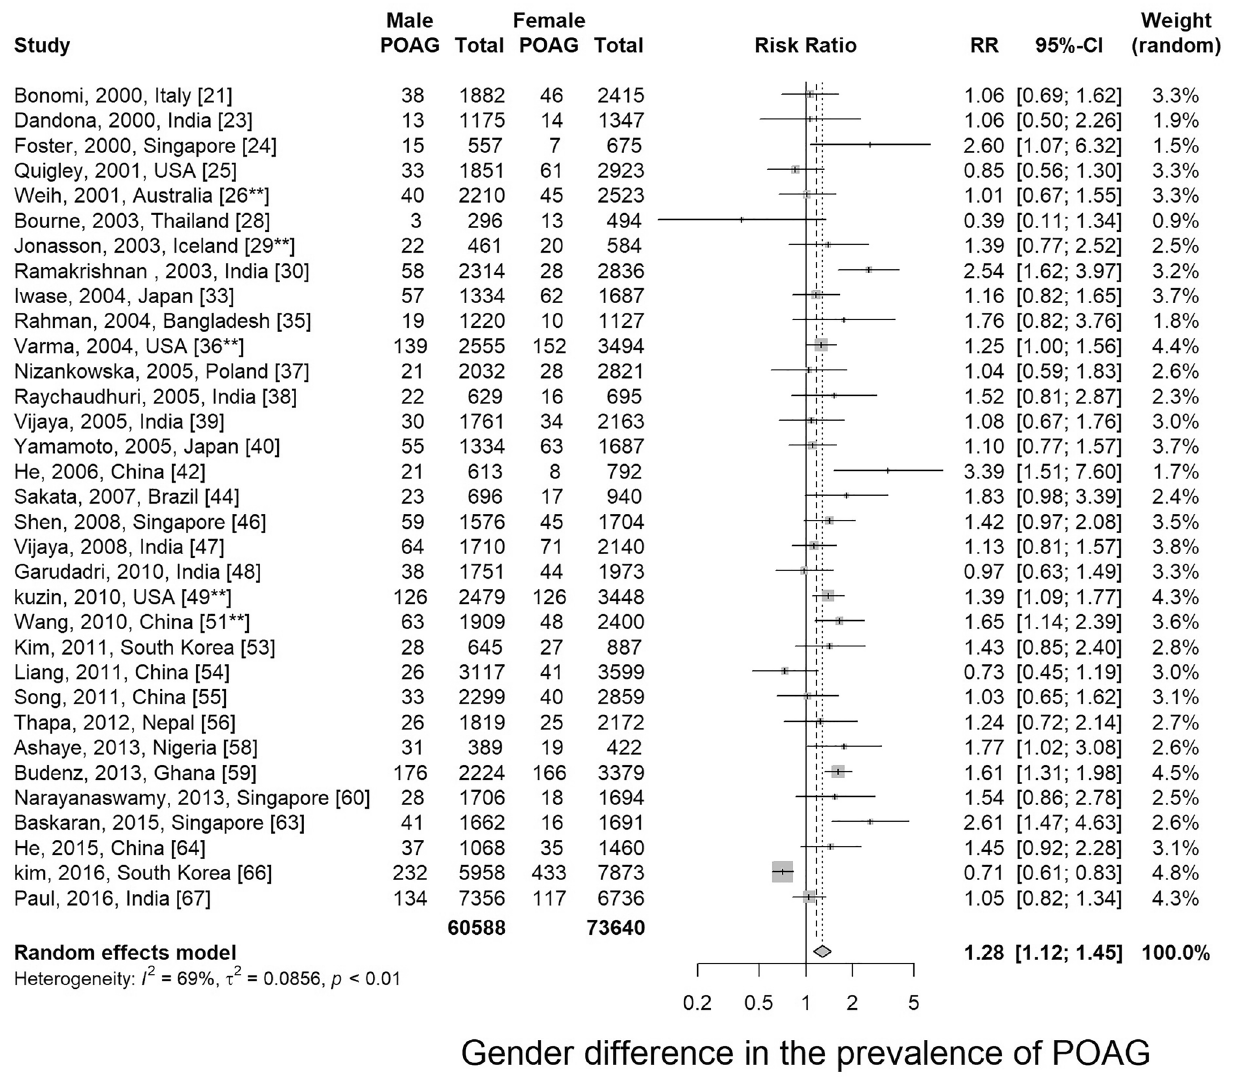
Figure 3. Gender comparison of primary open-angle glaucoma. POAG primary open-angle glaucoma. **Studies that reported prevalence of open-angle glaucoma (OAG), but not